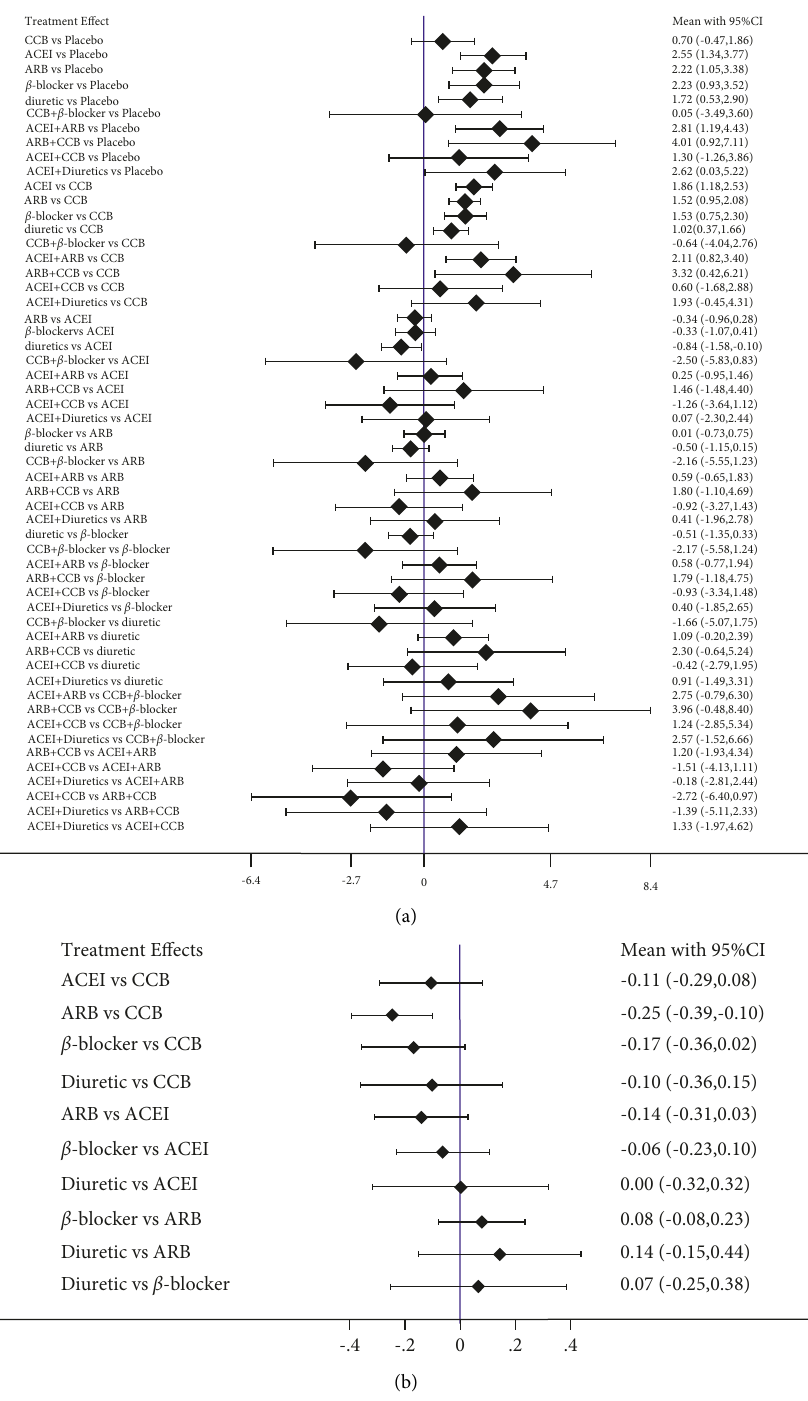
Figure 7: Absolute mean (95% credible interval, CRI) difference. (a) Flow-mediated dilation, (b) brachial artery diameter). ACEI: an- giotensin-converting enzyme inhibitors, ARB: angiotensin receptor blocker, CCB: calcium channel